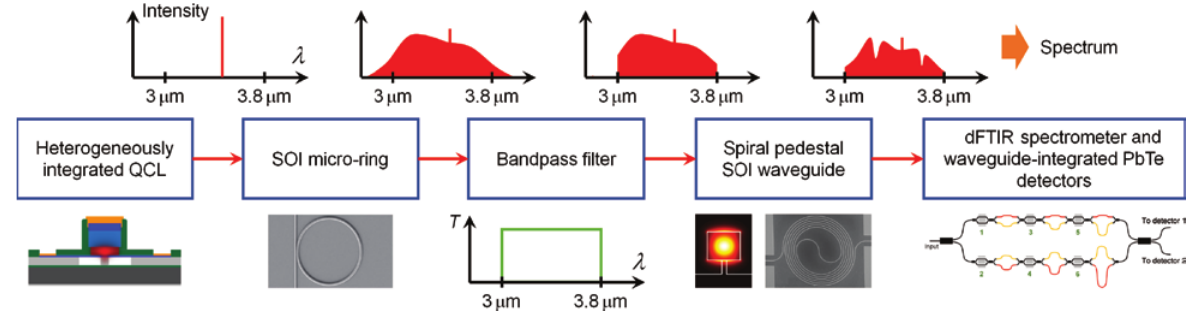
Figure 16: A hypothetical sensor-on-a-chip system for spectroscopic sensing across the 3–3.8- μ m band; the sensor is designed for hydro- carbon gas sensing in a chemically cluttered environment and all of its components are integrated